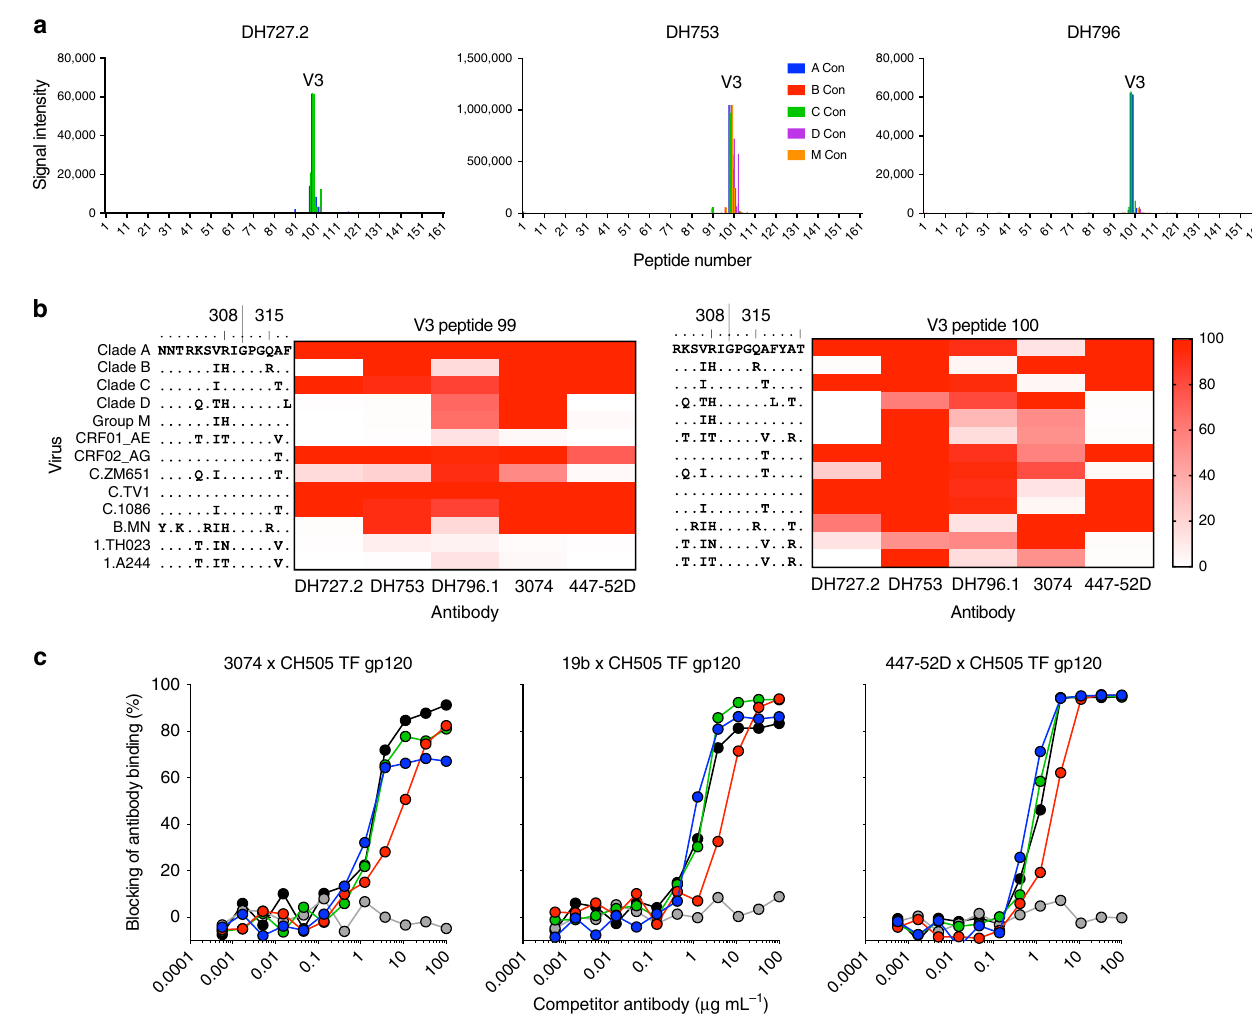
Fig. 3 Tier 2 HIV-neutralizing antibodies bind linear V3 epitopes in HIV-1 gp120. a Antibody reactivity with a linear peptide array spanning the gp120 subunit of HIV-1 Env. Peptides from consensus sequences for clades A (blue), B (red), C (green), and D (purple) and group M (orange) HIV isolates are shown as different colors. Each graph represents the magnitude of binding to each peptide for each antibody. b Heatmap of cross-clade V3 peptide binding by different V3-speci fi c antibodies. Binding to peptide number 99 (left) and 100 (right) are shown. Stronger binding is indicated by darker red colors. The sequences of the V3 peptides are shown on the left of the heatmap. HXB2 amino acid number is shown above the peptide sequences. Human monoclonal antibodies 3074 and 447 – 52D were included for comparison. c Macaque vaccine-induced antibody blocking of three human V3-speci fi c HIV-1 antibodies binding to CH505 TF gp120. Each curve shows the mean percent blocking of Env binding by DH727.2 (blue), DH753 (red), or DH796.1 (green). Mean of 2 independent experiments is shown. As a positive control the human antibody (black) was used to block itself. An anti-in fl uenza antibody (gray) was used as a negative control blocking antibody. Source data are provided as a Source Data fi